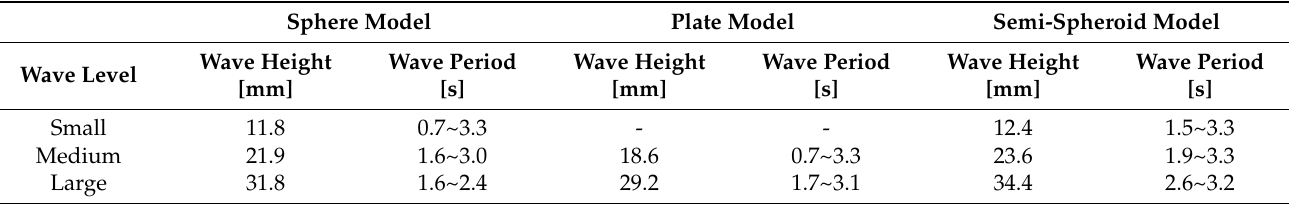
Table 3. Regular wave characteristics for the different models.